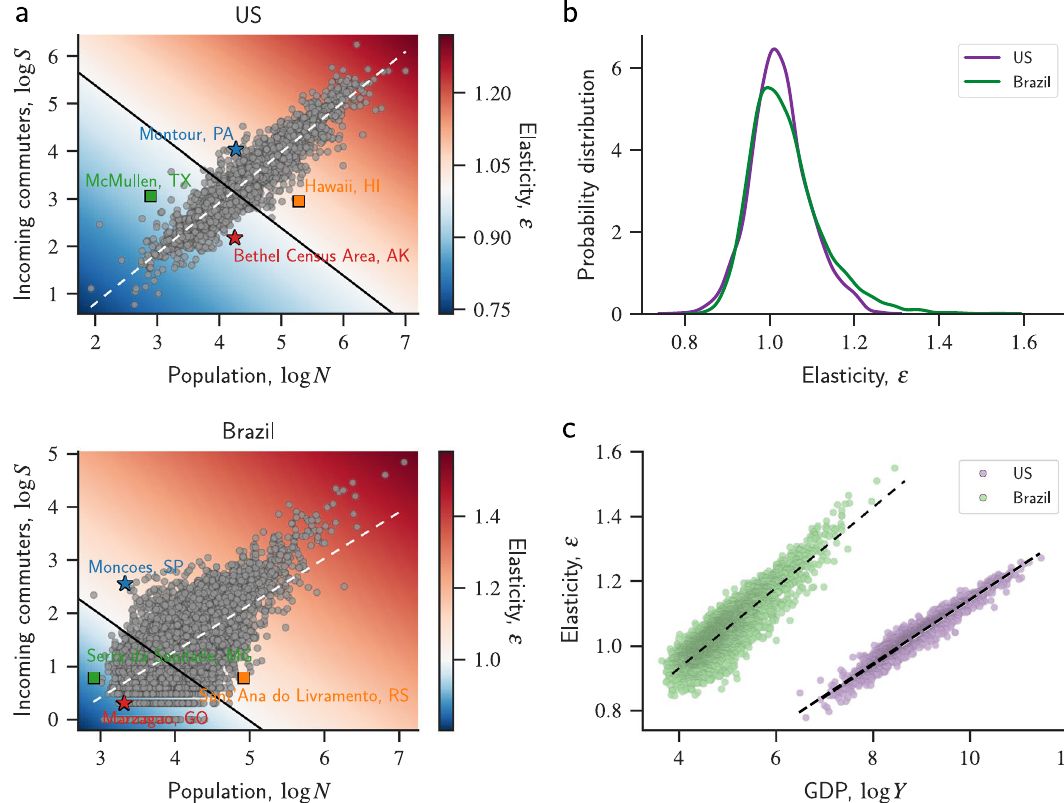
Figure 3. Elasticity of scale and the transition from decreasing to increasing returns to scale of GDP. ( a ) Dependence of the elasticity of scale ( ε ) on population ( N ) and incoming commuters ( S ) calculated from the translog model for US counties (upper panel) and Brazilian municipalities (lower panel). The color- coded background represents the elasticity of scale for each location in the plane population versus incoming commuters (on base-10 logarithmic scale) and the gray circles indicate the values of log N versus log S for each US and Brazilian urban area. The solid lines in both panels separate the region of decreasing returns to scale ( ε < 1 : bluish region) from the increasing returns to scale one ( ε > 1 : reddish region). We notice that urban areas are spread around the trend defined by S ∼ N γ (or log S ∼ γ log N , with γ = 0.87 ± 0.01 for the US and γ = 1.06 ± 0.01 for Brazil – white dashed lines) and that about 63% of urban areas in the US and Brazil display increasing returns to scale. The spread of the relationship between log S and log N allows urban areas with similar population sizes (as illustrated by the star markers) or similar incoming commuters (as illustrated by the square markers) to have significantly different values of elasticity of scale. ( b ) Probability distribution of the elasticity of scale estimated for all urban areas in the US (purple) and Brazil (green). The average elasticity of scale (cid:31) ε (cid:30) is slightly larger for Brazil than the US ( � ε � = 1.04 ± 0.001 and � ε � = 1.02 ± 0.001 , respectively), while the Brazilian distribution is significantly more skewed to the right when compared with the US case (skewness = 1.1 and skewness = 0.3 , respectively). ( c ) Relationship between the elasticity of scale and the GDP of urban areas in the US (purple) and Brazil (green). The GDP of Brazilian municipalities has been converted from Brazilian Real (BRL) to their equivalent values in US Dollars (USD) in this plot. We notice that the elasticity of scale is approximately proportional to the logarithm of urban GDP (as indicated by the dashed lines) with the constant of proportionality ( κ ) larger for Brazil than the US ( κ = 0.124 ± 0.001 and κ = 0.099 ± 0.001 , respectively). We also observe that the elasticity of scale of urban areas with similar GDP is always larger for Brazilian municipalities than US